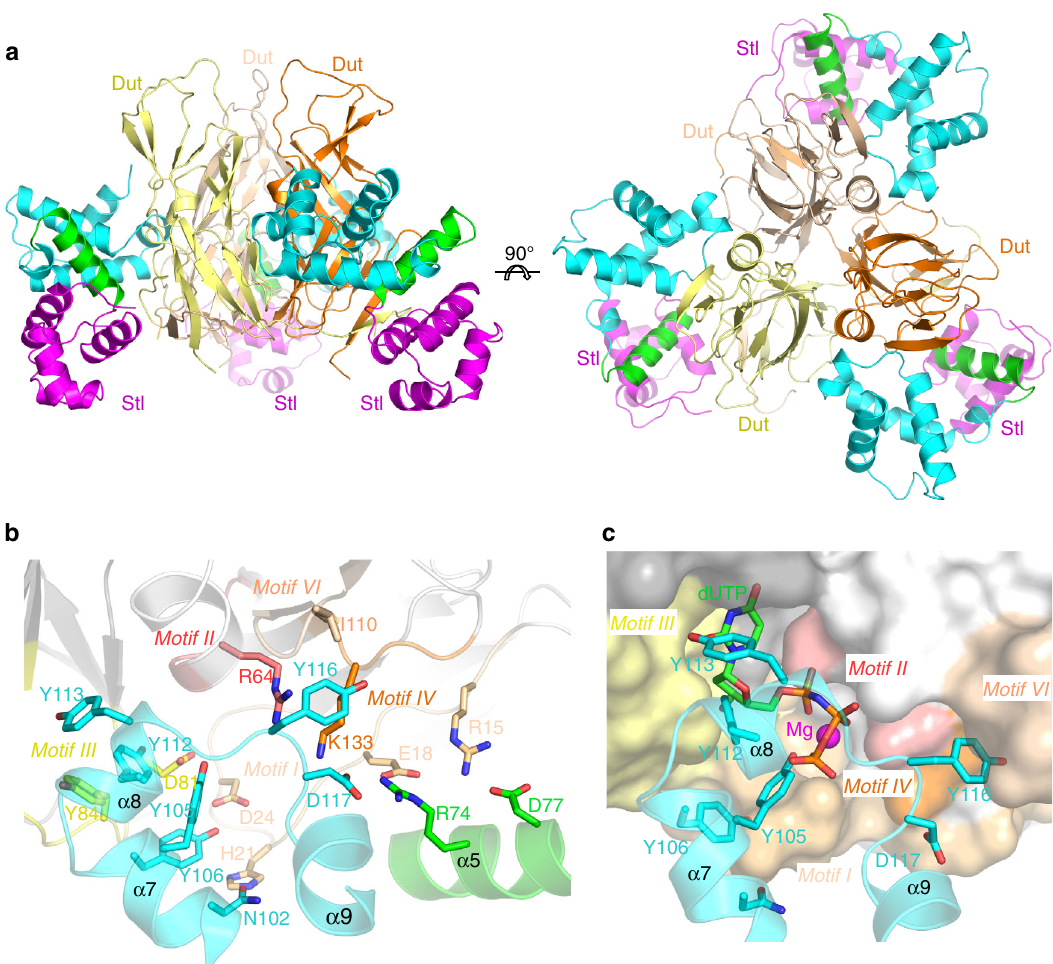
Fig. 3 Crystal structure of the BovI-Stl N-ter -Dut ϕ 11 complex. a Structure of the complex between the trimeric Dut from phage ϕ 11 (protomers coloured in different tones of yellow-orange) and three molecules of BovI-Stl N-ter (protomers coloured as in Fig. 1b). Two orthogonal views are shown. b Close-up view of the interaction of a protomer of BovI-Stl N-ter with the Dut ϕ 11 trimer. Notice that only two of the three protomers of Dut ϕ 11 contact each Stl molecule. Dut catalytic motifs are highlighted in different colours and labelled. The residues involved in interactions are shown as sticks, labelled and coloured by atom type with the carbons in the same colour as the corresponding molecule. For clarity, only the structural elements of BovI-Stl N-ter involved in the interaction are shown and labelled . c Stl mimics the interactions of the dUTP substrate with Dut ϕ 11. The substrate dUTP was placed in the active centre of Dut ϕ 11 in complex with BovI-Stl N-ter by superimposing the structure of Dut ϕ 11-dUTP (PDB 4GV8) and is shown as sticks with carbon atoms in green. The Mg ion chelated by the dUTP is shown as a magenta sphere. Dut ϕ 11 is represented in surface and BovI-Stl N-ter in cartoon and sticks. Structural elements and BovI-Stl N-ter interacting residues are labelled as well as conserved catalytic motifs of Duts and coloured as in b . The omit electron density map is shown in Supplementary Fig. 13. Source data are provided as a Source Data fi